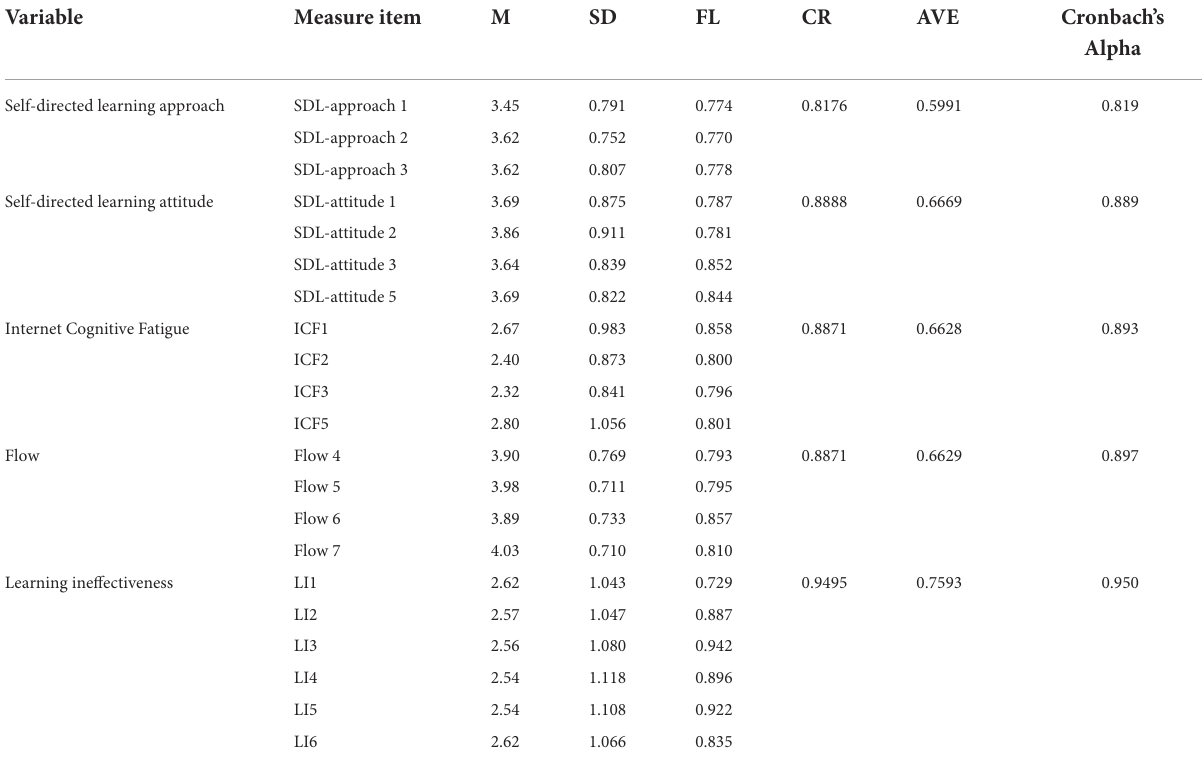
TABLE 1 Dimension reliability and validity analysis.